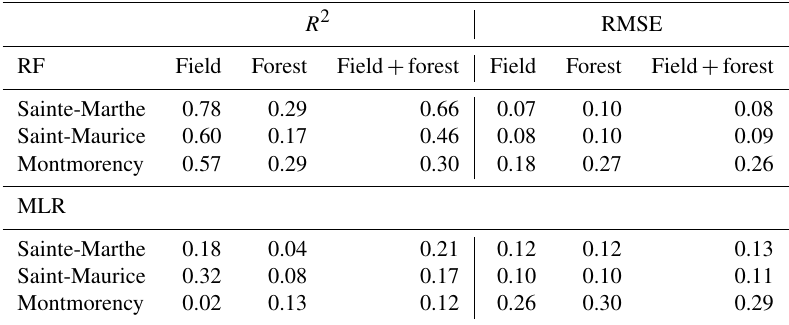
Figure 9. RF model performance against observed snow depths. (a) Sainte-Marthe, (b) Saint-Maurice, and (c) Montmorency. The stippled line depicts the 1 : 1 relationship. Table 3. Comparison of RF and MLR model performances of study